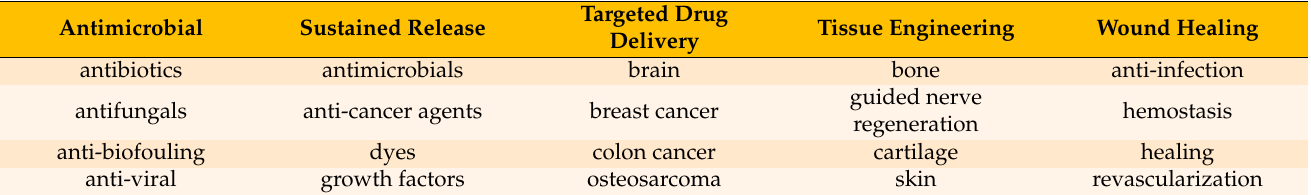
Table 2. Potential applications of metalized HNTs.